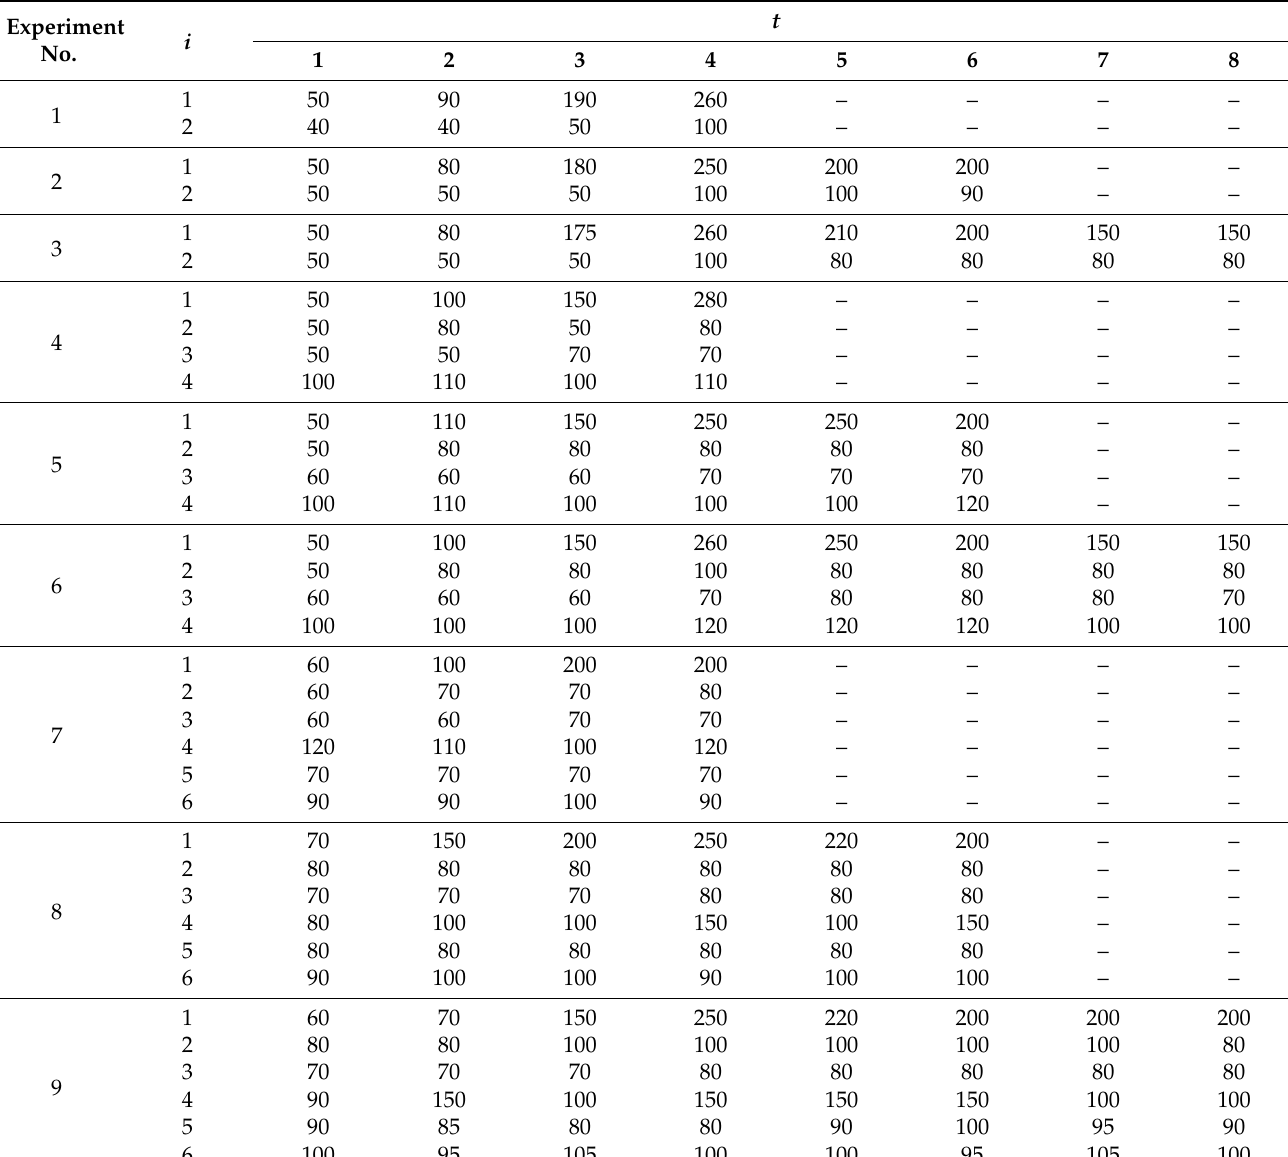
Table A1. Production capacity of